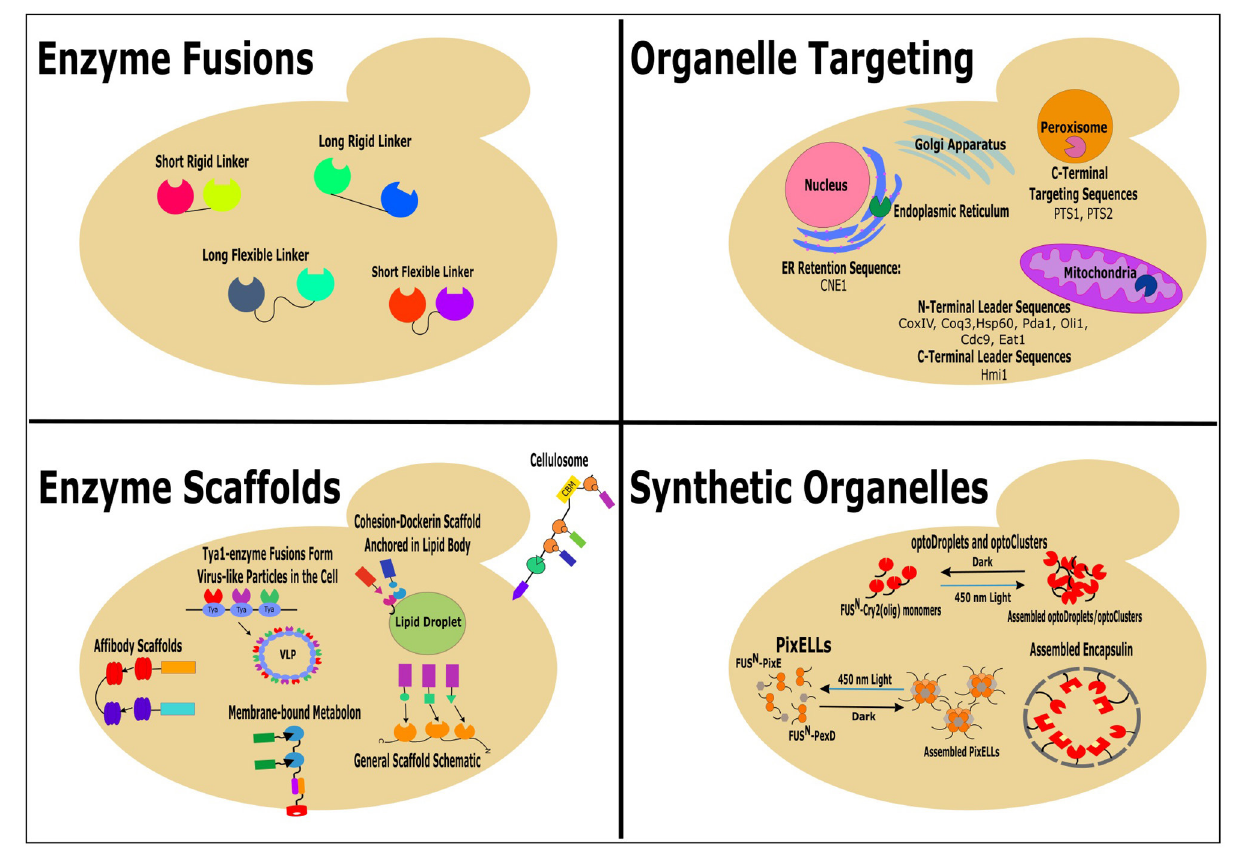
FIGURE 1 | Successful colocalization strategies: enzyme fusions, enzyme scaffolds, organelle targeting, and synthetic organelles, for increasing the production of non-native products in